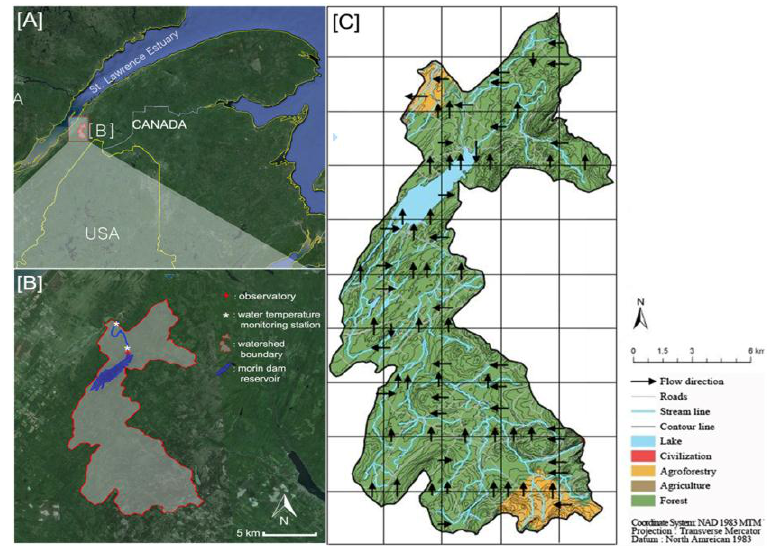
Figure 1. ( A ) Study area; ( B ) drainage basin showing location of reservoir; and ( C ) land use map showing hydrological units (whole squares) and arrows indicate water routing used for CEQUEAU.